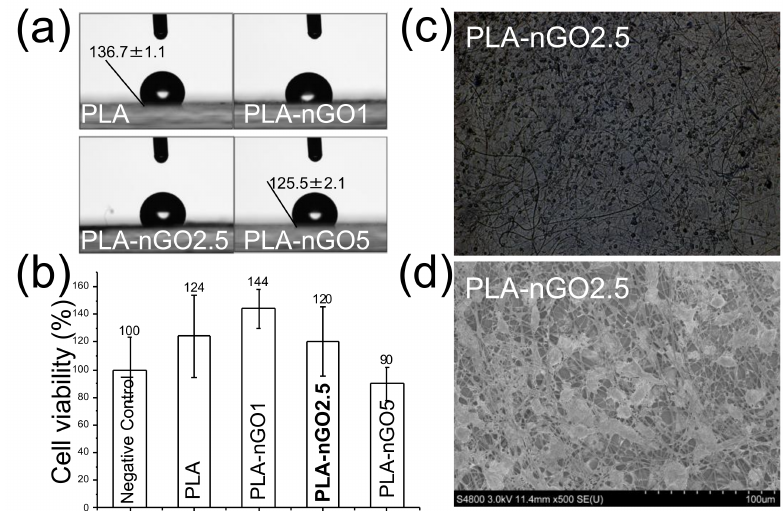
Figure 5. ( a ) Water contact angle measurements on PLA, PLA-nGO1, PLA-nGO2.5, and PLA-nGO5 fibers; ( b ) The relative cell viability of PLA, PLA-nGO1, PLA-nGO2.5, and PLA-nGO5 fibers; ( c ) Optical microscopy images of PLA-nGO2.5 fibers after 4 days of cell culture; ( d ) SEM image of